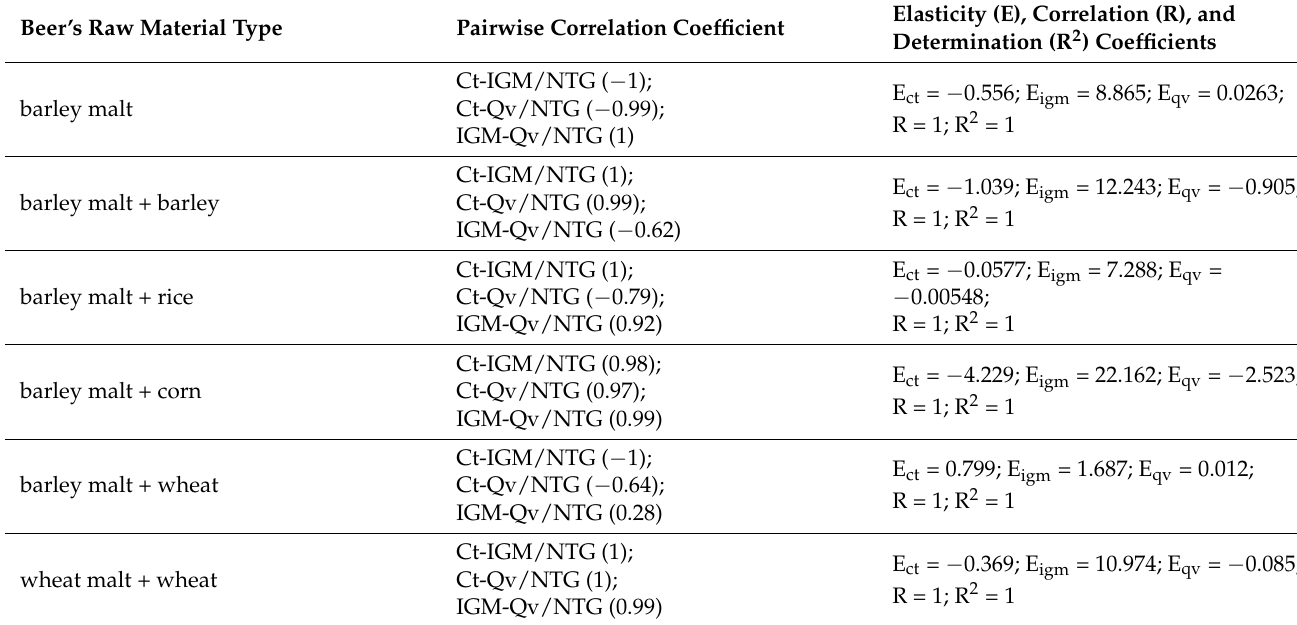
Table 8. Samples of pairwise correlation characteristics (reliability limit p <